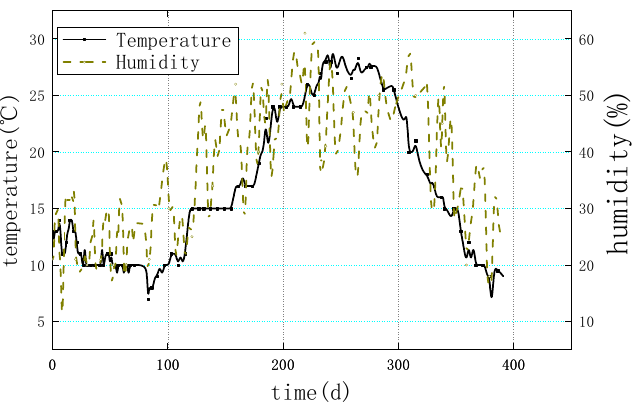
Figure 4. Time ‐ history plots of the temperature and humidity of the atmosphere of the laboratory room.